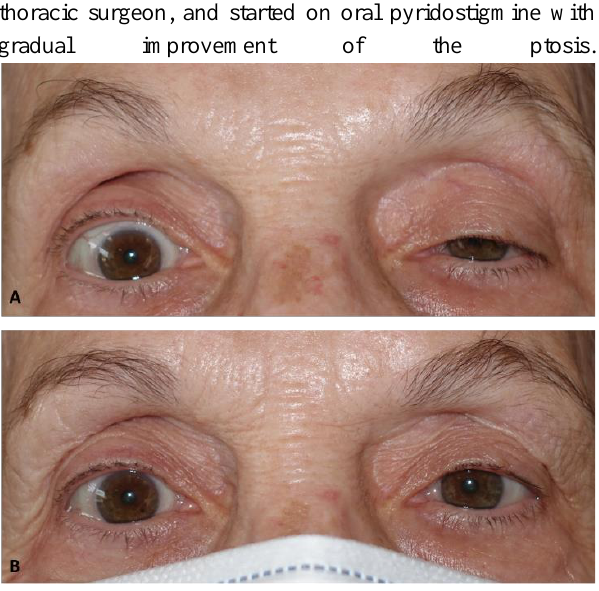
Figure 1 : A: Clinical image in primary gaze, showing left- sided ptosis and right palpebral retraction. B Image after a 2- minute ice-pack test, showing resolution of the ptosis.